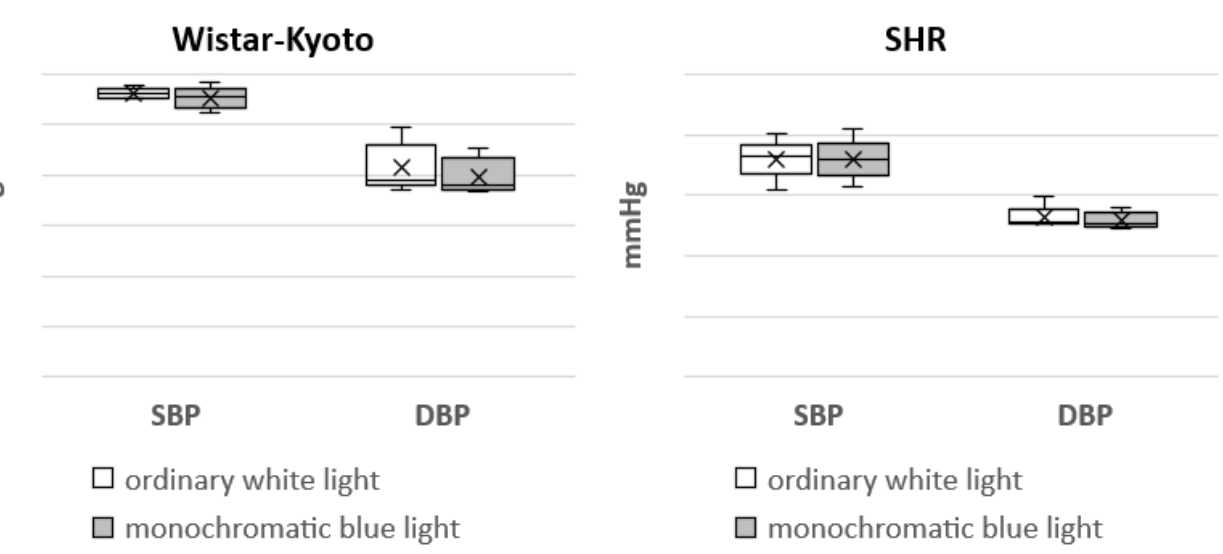
Figure 4. Mesor of SBP and DBP in Wistar–Kyoto and SHR rats under the standard light pattern (12 h:12 h) with ordinary white light and monochromatic blue light.